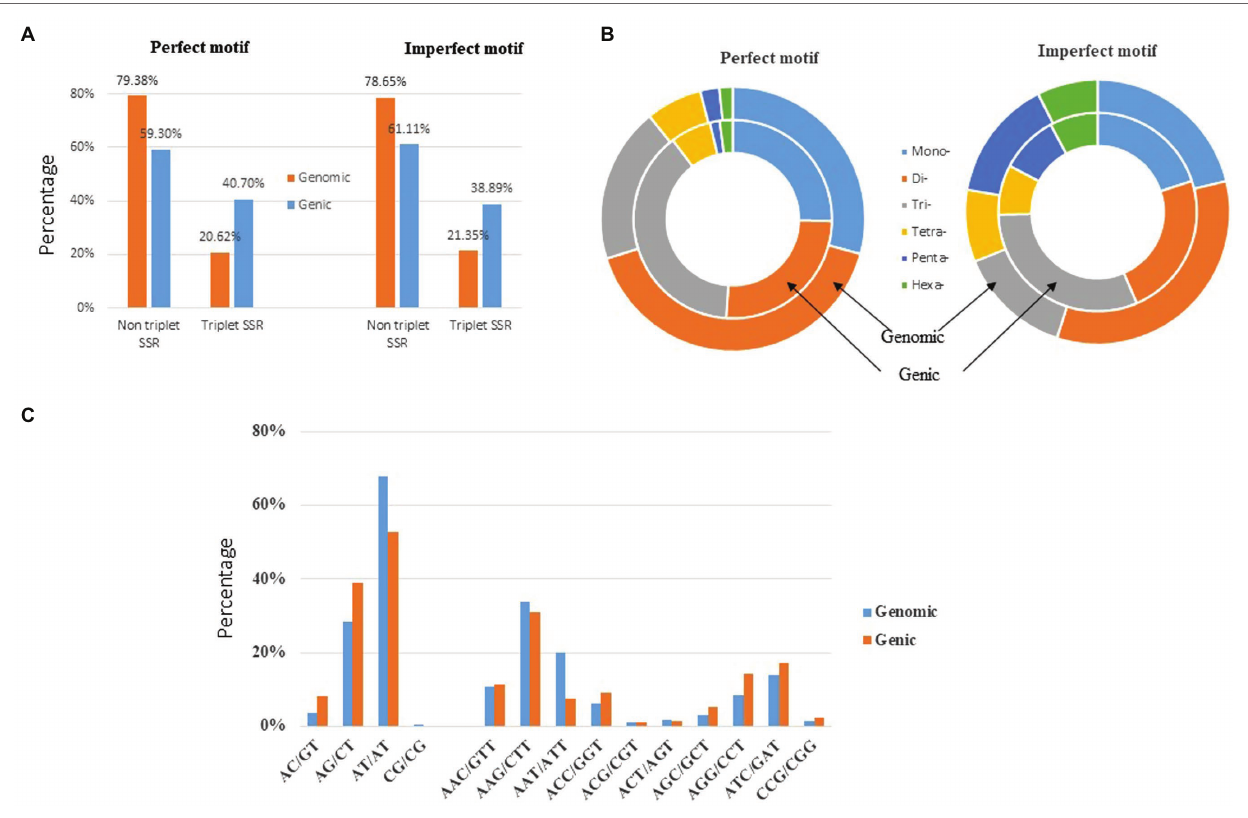
FIGURE 5 | Distribution of microsatellite sizes in the cabbage genome. (A) Non-triplet SSR vs. triplet SSR in both perfect and imperfect motifs. (B) Distribution of repeat types within perfect and imperfect SSR motifs. (C) A comparison between di- and trinucleotide repeats in both the gene space and full genomic